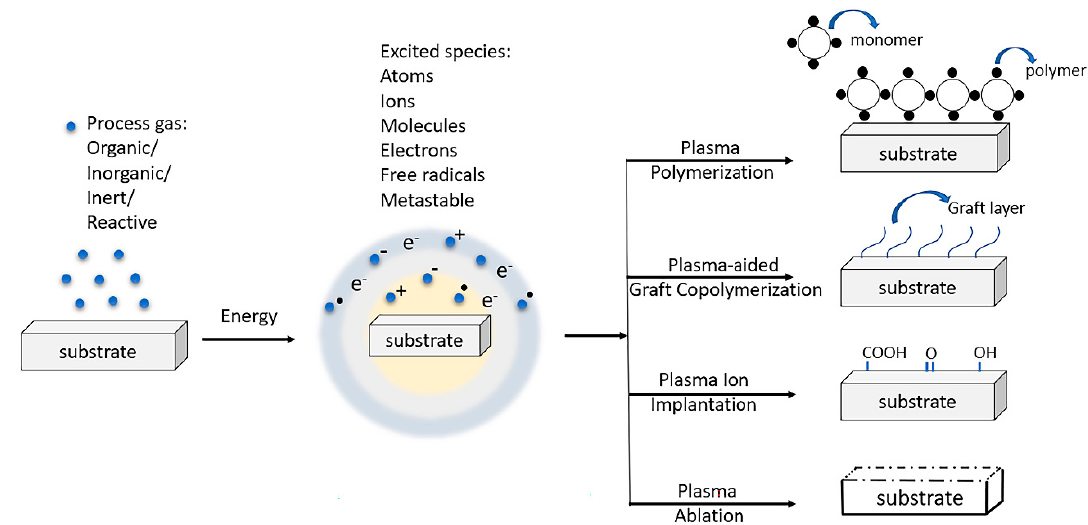
Figure 2. Different interactions between plasma and substrate.